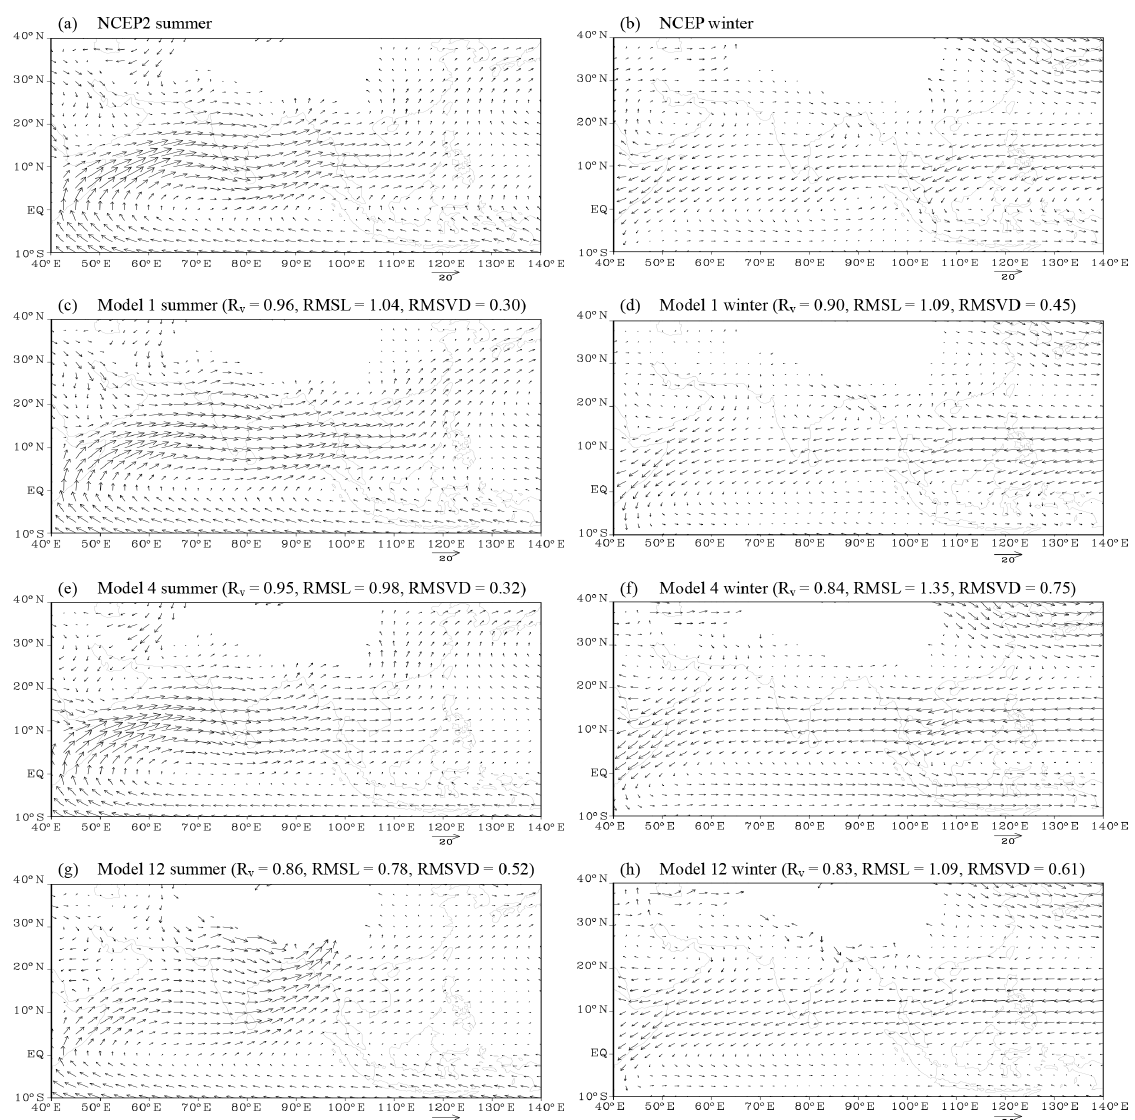
Figure 7. Climatological mean 850hPa vector winds in summer and winter for the NCEP Reanalysis 2 data and the results of historical simulations obtained from three CMIP5 models during the period from 1979 to 2005. The vector similarity coefficient ( R v ) , normalized RMSL, and normalized RMSVD are also shown at the top of each panel. The vectors are set to a missing value in the areas with a topography higher than